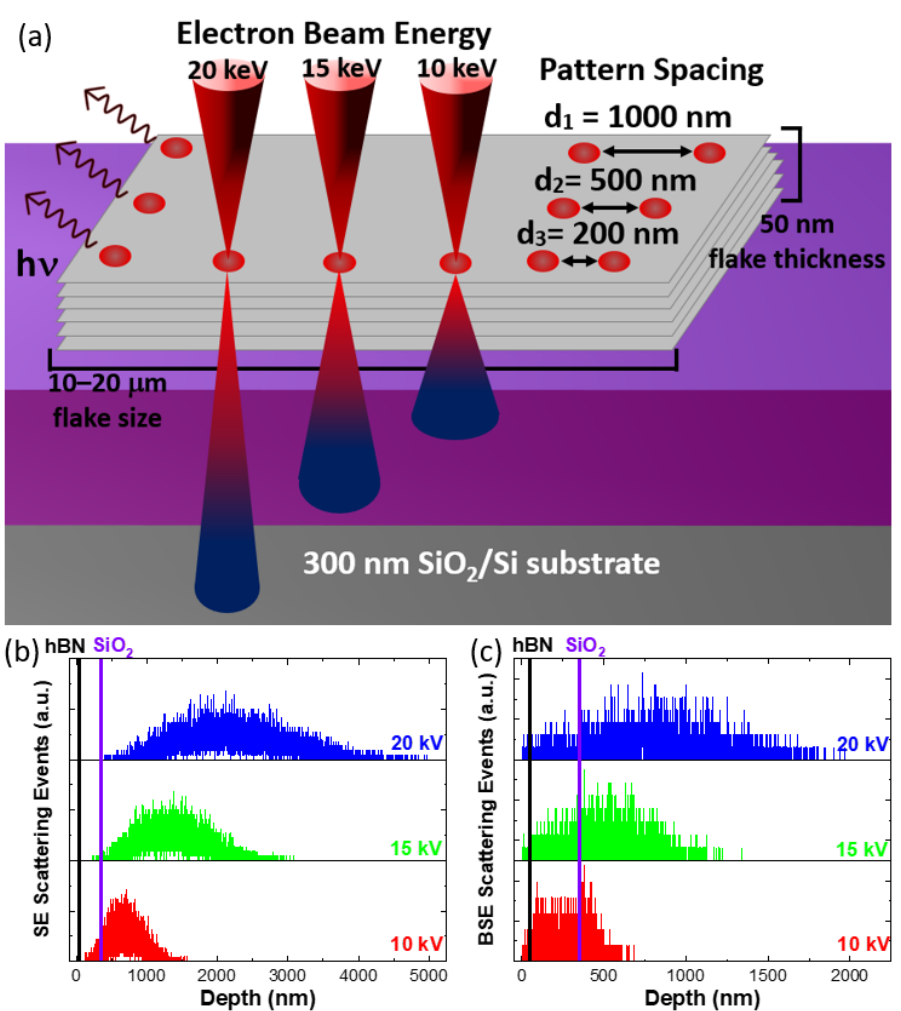
Figure 1. ( a ) Sketch of the different irradiation processes performed on the hBN flakes. Monte Carlo simulation of the depth penetration at different beam energies: ( b ) secondary electron-generating scattering events and ( c ) backscattering electron-generating scattering events. The black and purple vertical lines indicate the thickness of the hBN and of the SiO 2 , respectively.